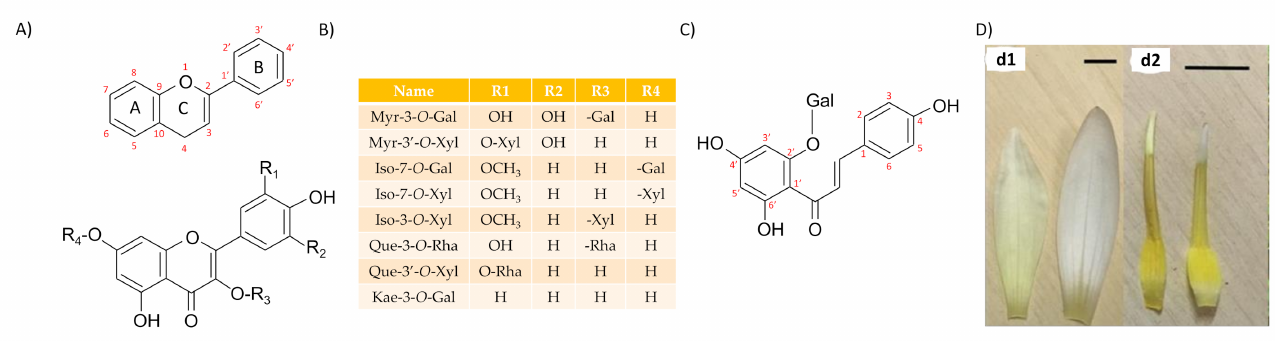
Figure 2. Chemical structures and names of the main antioxidant flavonoids from N. lotus stamen extracts. ( A ) General chem- ical structure with atom numbering of a flavonoid. ( B ) Chemical structures of the main flavonol glycosides extracted from N. lotus stamen extract. ( C ) Chemical structure of chalcononaringenin-2”- O -galactoside from N. lotus stamen extract. Myr: myricetin; Iso: isorhamnetin; Que: quercetin; Kae: kaempferol; Gal: galactoside; Xyl: xyloside; Rha: rhamnoside. ( D )